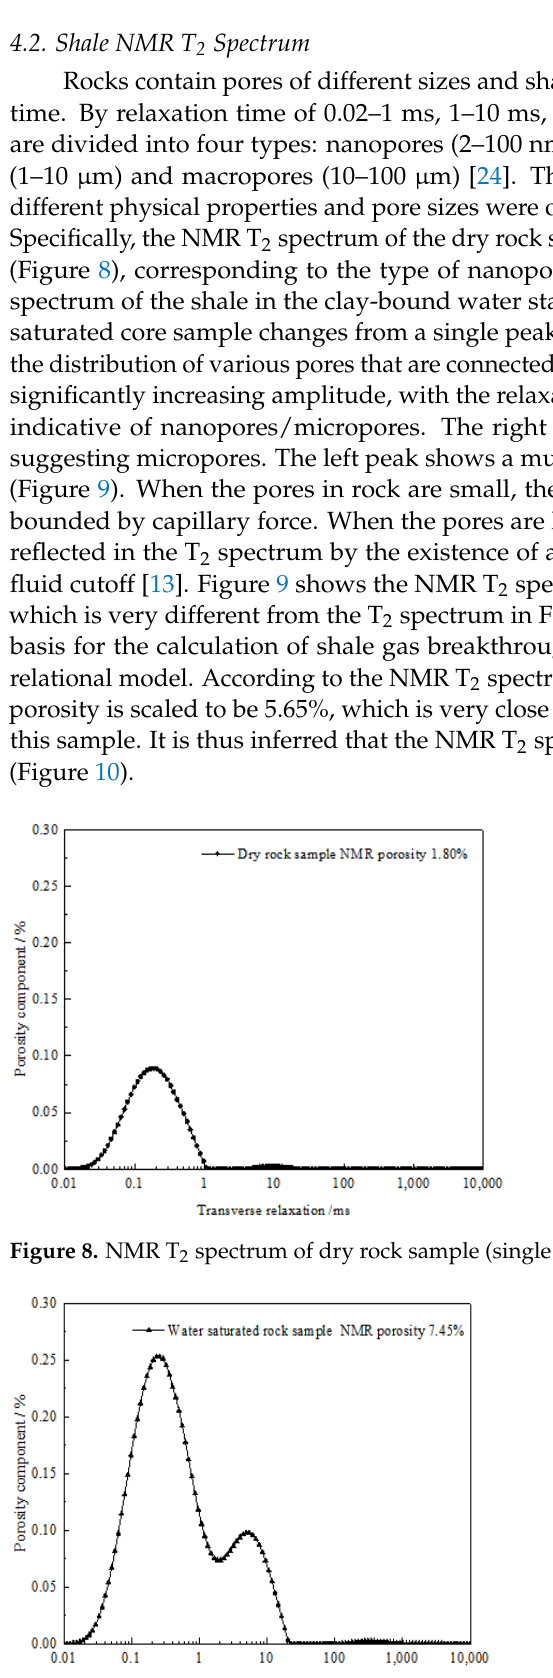
Figure 10. NMR T2 spectrum of original rock sample-liquid logging porosity (5.42%). 4.3. Relationship between Gas Breakthrough Pressure and Relevant Parameters Studies on shale pore characterization indicate that marine shale has the highest pore volume and the continental and transitional shales are similar in pore volume. The marine shale has a pore volume two to three times that of the other two lithofacies and provides the best storage space. According to the pore volume distribution, mesopores take the largest proportion ( ˃ 60%) in three facies of shale, while micropores and macropores are